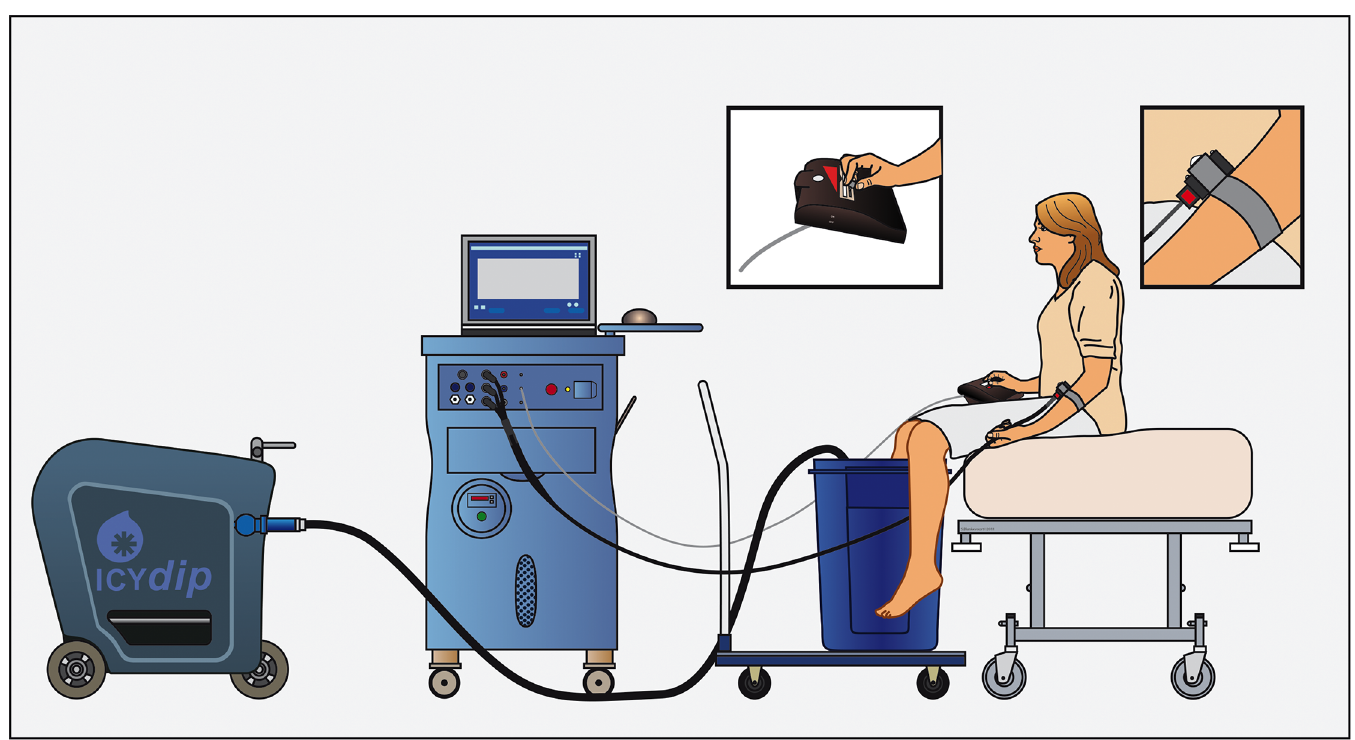
Fig 2. Consort flow diagram. The test stimulus temperatures (heat pain) as determined prior to treatment averaged to 47 ± 0.5°C, 46.6 ± 0.5°C and 46.9 ± 0.5°C on placebo, morphine and tapentadol experimental sessions (one-way anova: NS). The target conditioning stimulus temperatures were 7.9 ± 0.5°C, 8.1 ± 0.6°C and 8.3 ± 0.6°C on placebo, morphine and tapentadol experimental sessions (one-way anova: